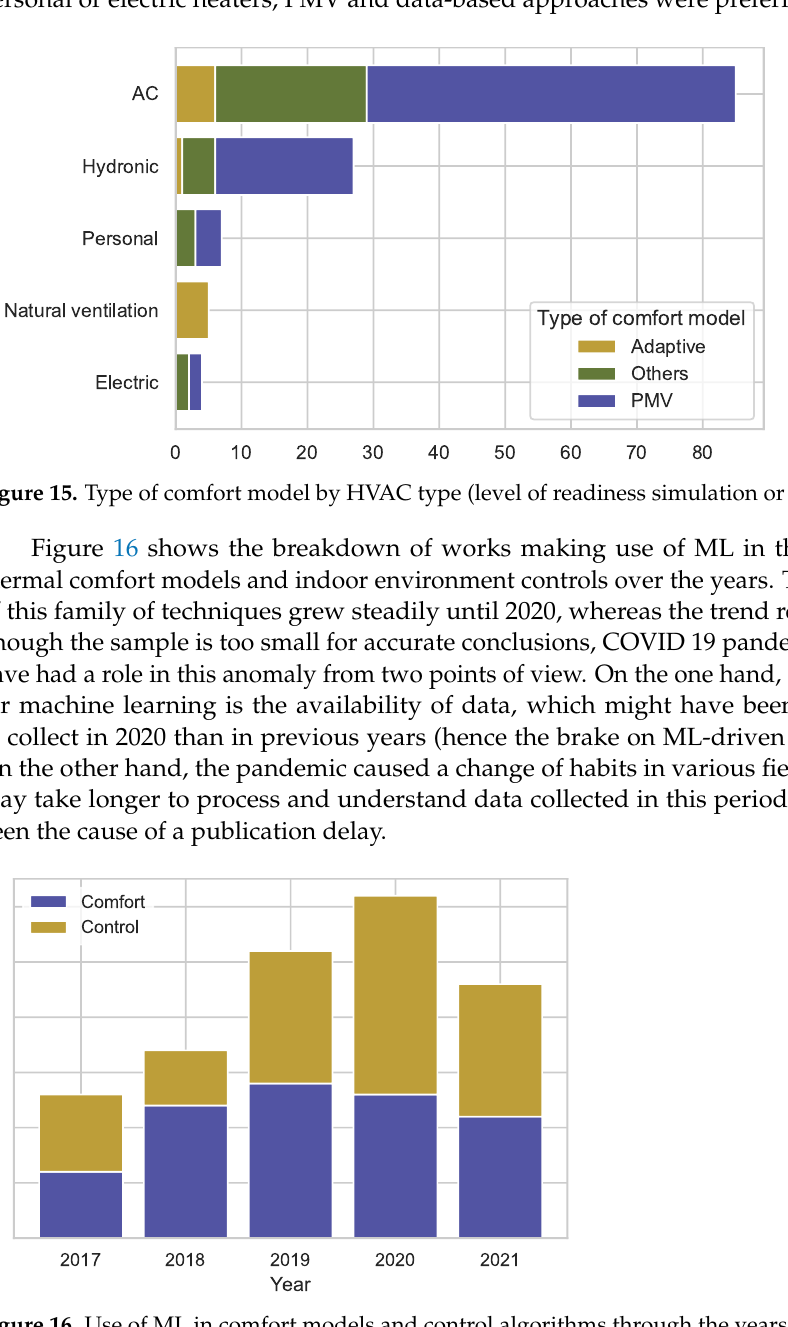
Figure 16. Use of ML in comfort models and control algorithms through the